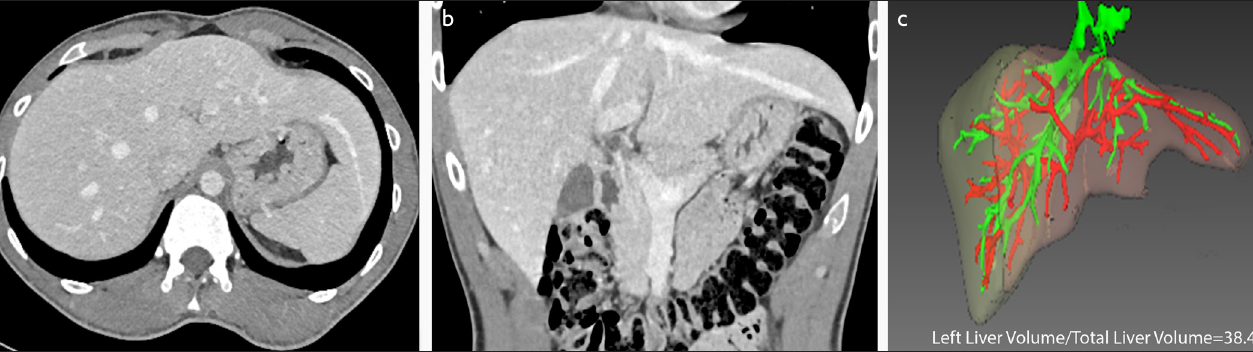
Figure 2. a-c. Axial (a) and coronal (b) computed tomography images of a case in which the left lobe of the liver extends to the left hypochondrium. In the 3D volumetric evaluation (c), ratio of the left lobe volume to the total liver volume was calculated as 38.4%